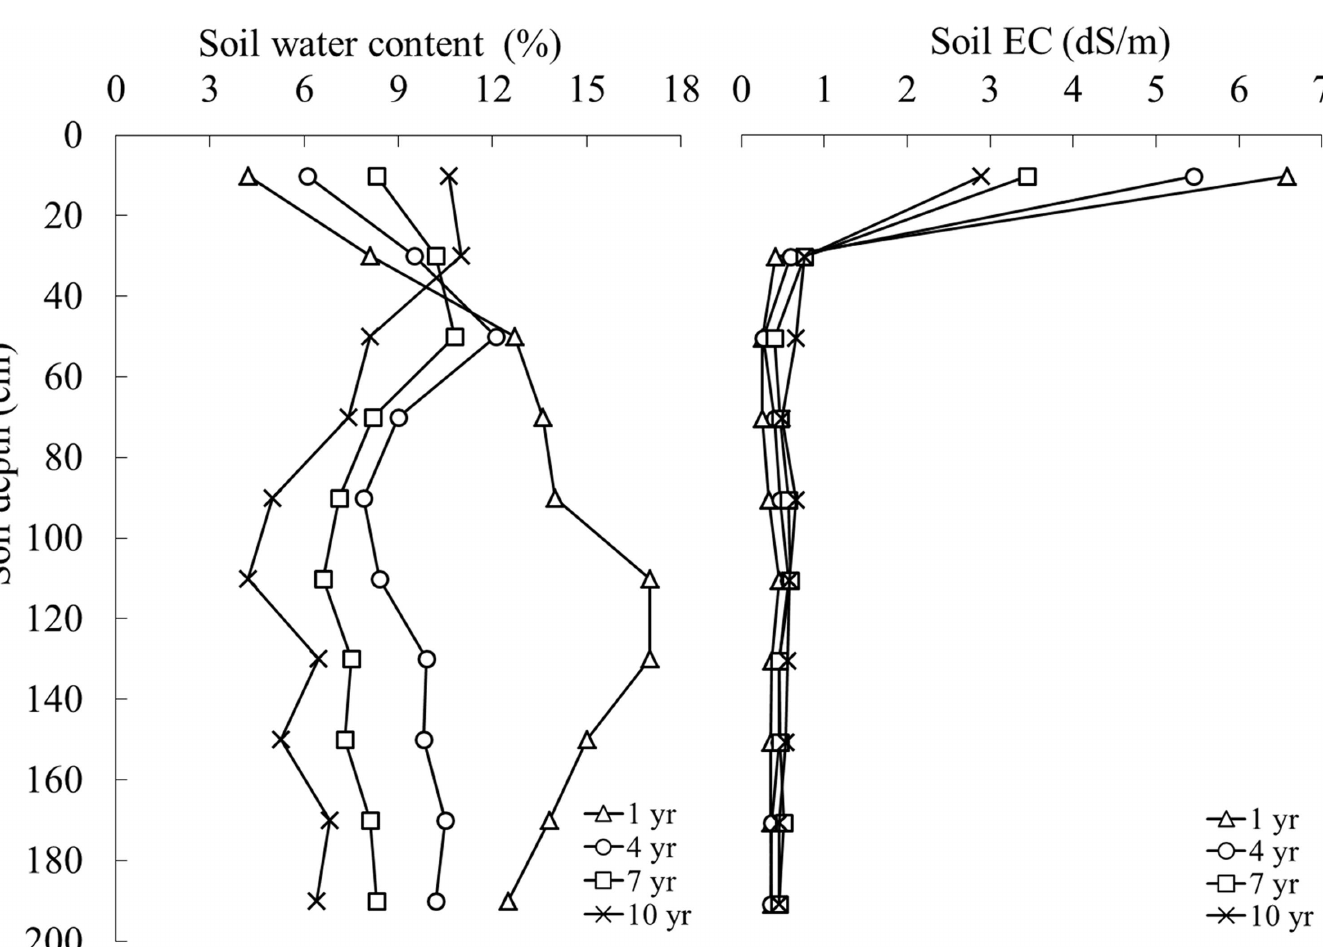
Fig 6. Depth profiles of soil moisture and salinity in shelterbelts of different